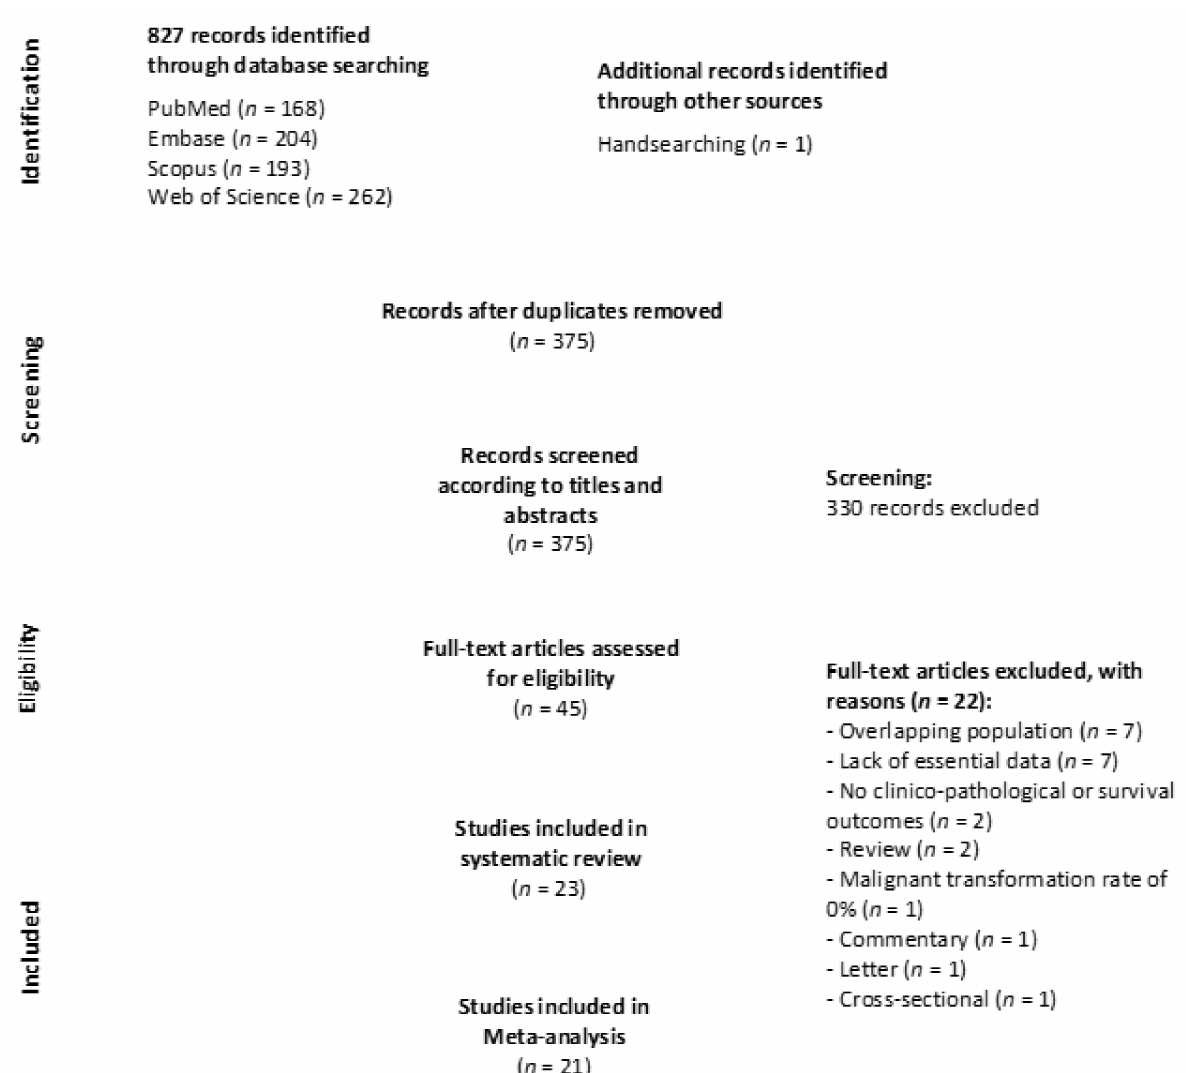
Figure 1. The flow diagram depicts identification and selection process of studies addressing the behavior